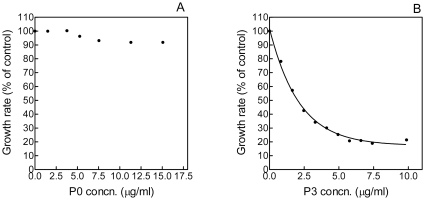
Effects of P0 and P3 on seeded growth of HA.A. Plot of HA growth rate against P0 concentration. B. Plot of HA growth rate against P3 concentration. The half-life of the one-phase exponential-decay curve (IC50) is 1.48.